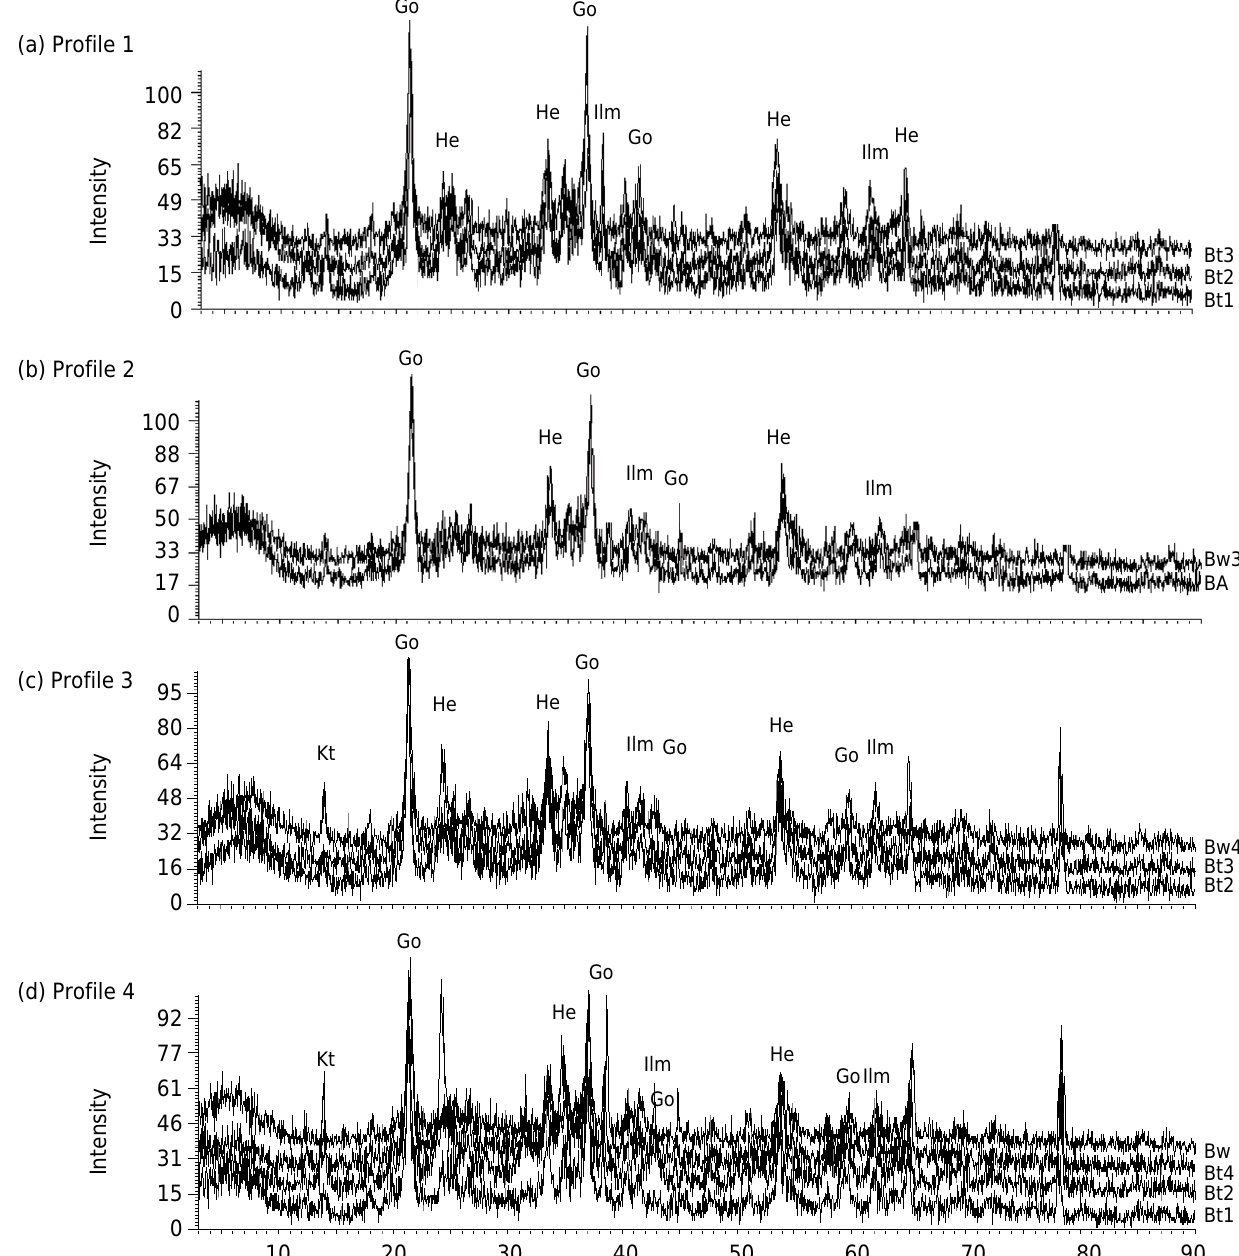
Figure 4. X-ray diffraction patterns of clay fraction (iron oxide concentration) in horizons from soil profiles located in the Rio de Janeiro State, Southeastern Brazil. Go: goethite; Kt: